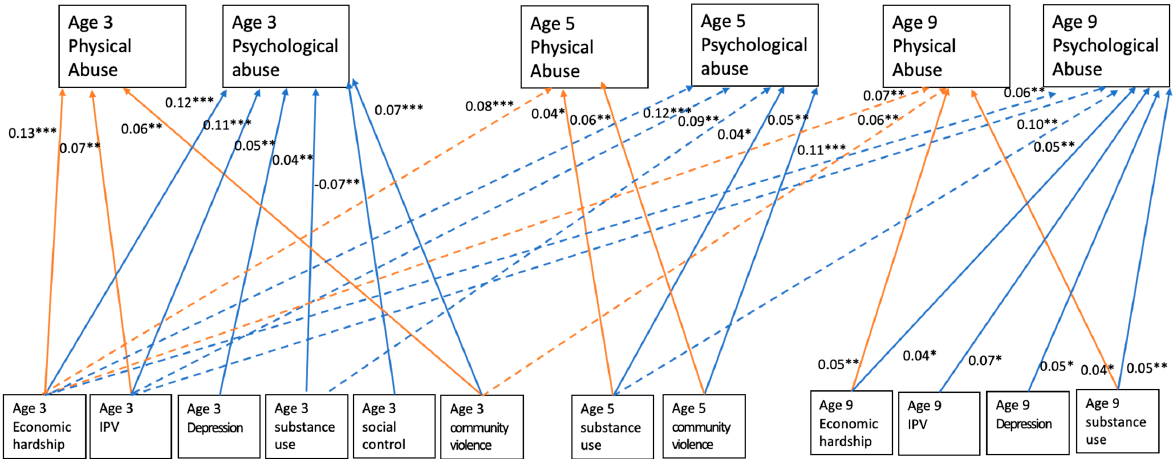
Figure 1. Predictors of physical abuse and psychological abuse at ages 3, 5, and 9. Note: Solid lines indicate concurrent associations and dashed lines indicate lagged effects. * p < 0.05, ** p < 0.01, *** p < 0.001. IPV = intimate partner violence.